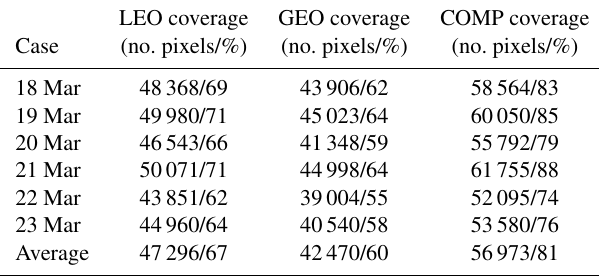
Table 4. The AOD coverage for the individual LEO and GEO re- trievals and for the daily AOD composite product (COMP). We present the coverage statistics for 6 days, including the 18 and 23 March case studies analyzed in this paper. The number of valid AOD retrievals across our AOD composite domain along with the percent coverage based on the total number of available grid boxes are